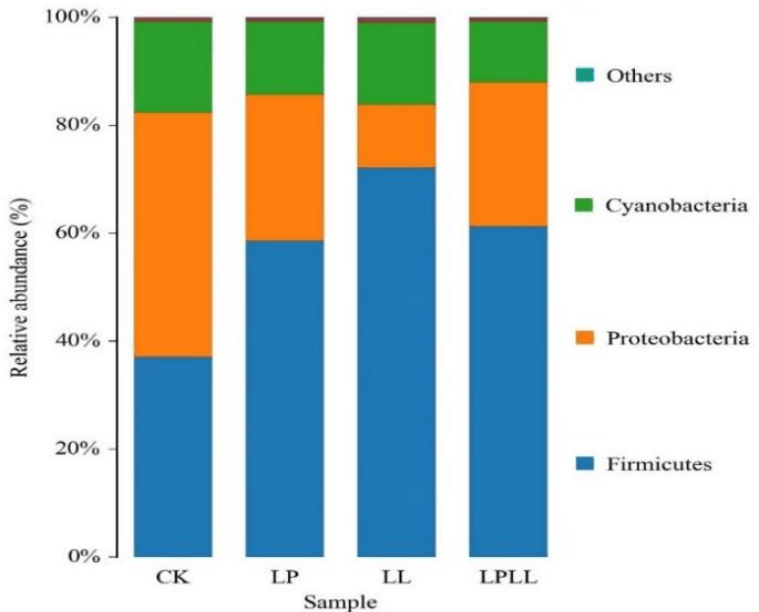
Figure 4. UPGMA cluster analysis of bacteria relative abundance on phylum level. CK: fresh sug- arcane juice; LL: sugarcane juice with added HNK10; LP: sugarcane juice added with HNK21; LPLL: sugarcane juice treated with HNK10 + HNK21 was added.